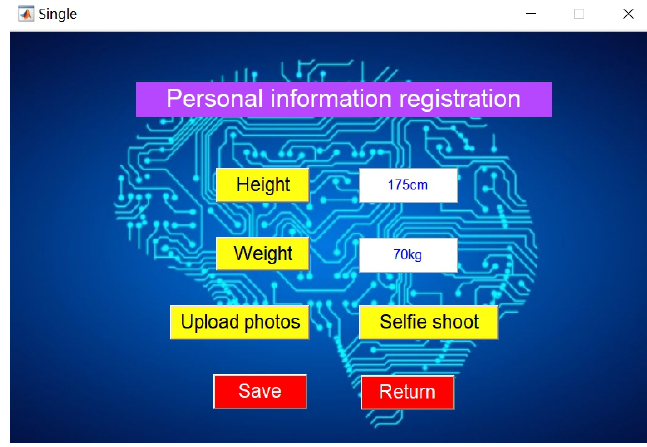
Figure 2. Interface information of personal information